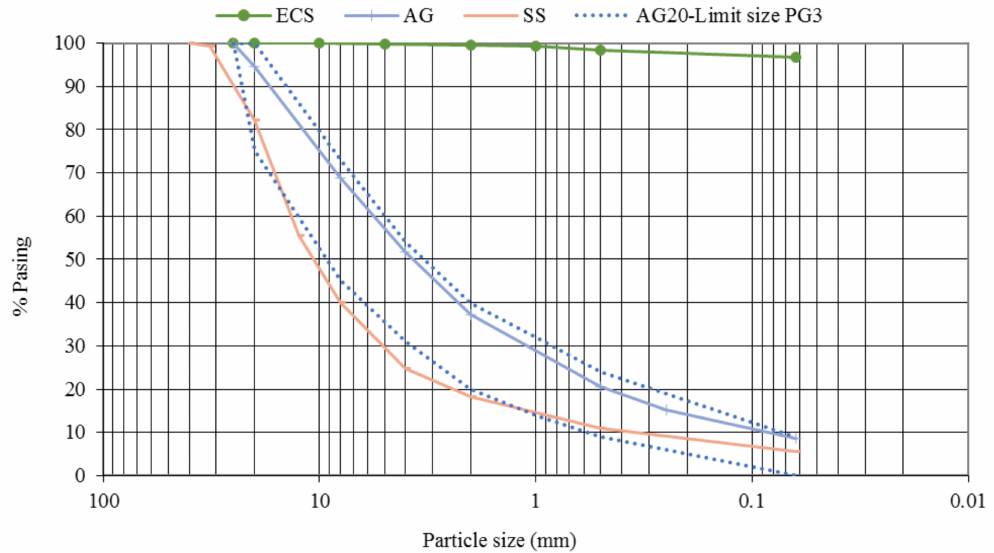
Figure 2. Particle size distribution